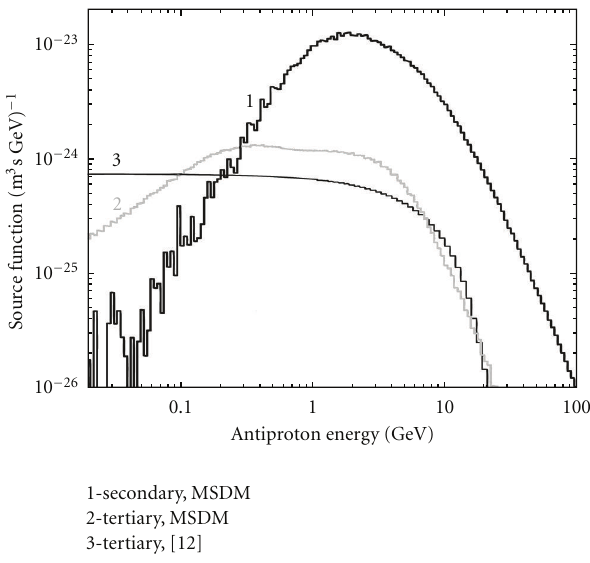
Figure 4: The interstellar secondary antiproton production spectra simulated using the MSDM and [12] cross